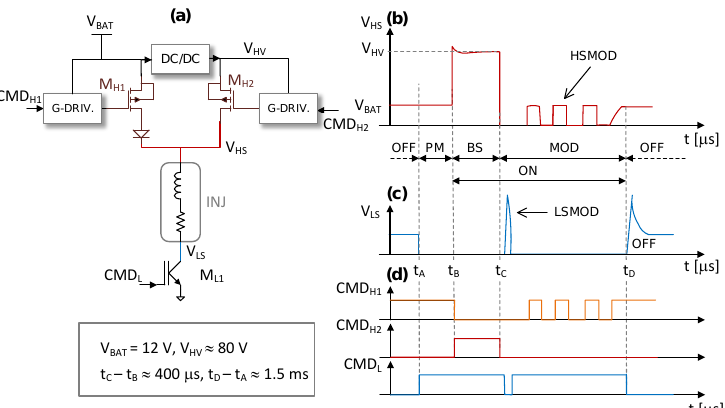
Figure 1. ( a ): Dual-voltage driver for fuel-injection device in GDI and common-rail engines. ( b ): Voltage waveform at the high-side terminal. ( c ): voltage waveform at the low-side terminal. ( d ): command waveforms of low and high-side switches (high-level corresponds to the